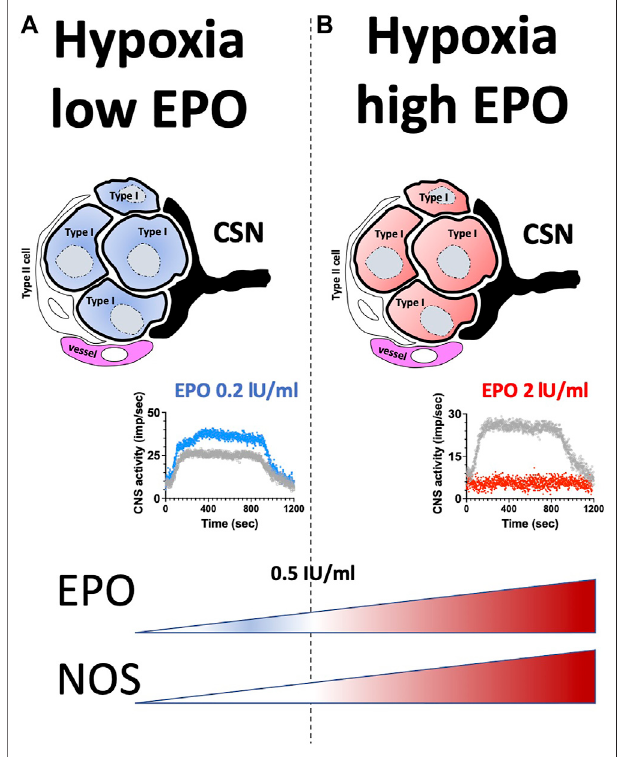
FIGURE 7 | Graphical abstract. (A) low EPO concentration; (B) high EPO concentration.